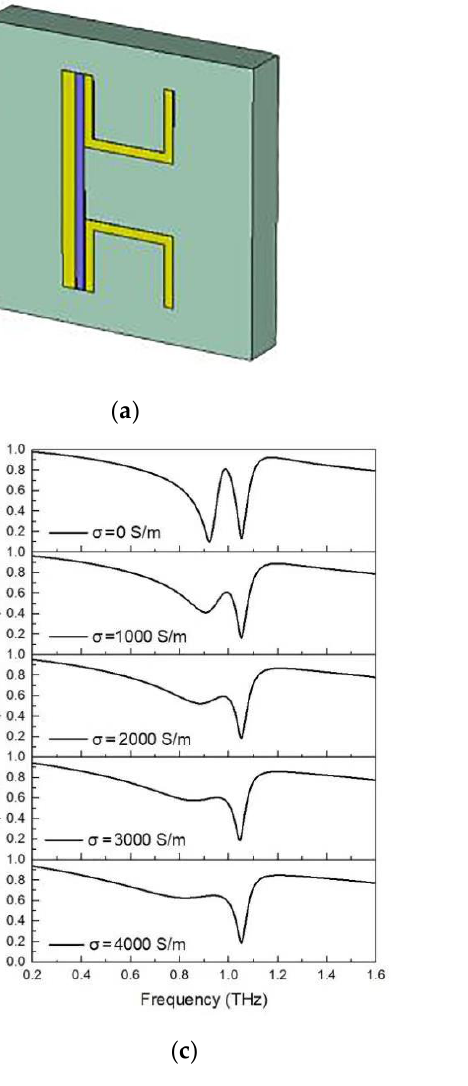
Figure 6. The effect of adding photosensitive Si into the metamaterial structure on the transmission characteristics. ( a ) Structure of buried photosensitive Si with different conductivity between CW and USRs; ( b ) Structure of buried photosensitive Si with different conductivity between USR pairs; ( c ) The transmission spectra buried with different conductivity photosensitive Si between CW and USRs. As the conductivity of Si battery increases, the LSP resonance disappears, so only LC resonance trough remains, while the EIT-like window disappears completely; ( d ) The transmission spectra of photosensitive Si buried with different conductivity between USR pairs. When the conductivity of the Si battery increases, the current will be limited around the CW, which cause the EIT-like window to completely disappear.